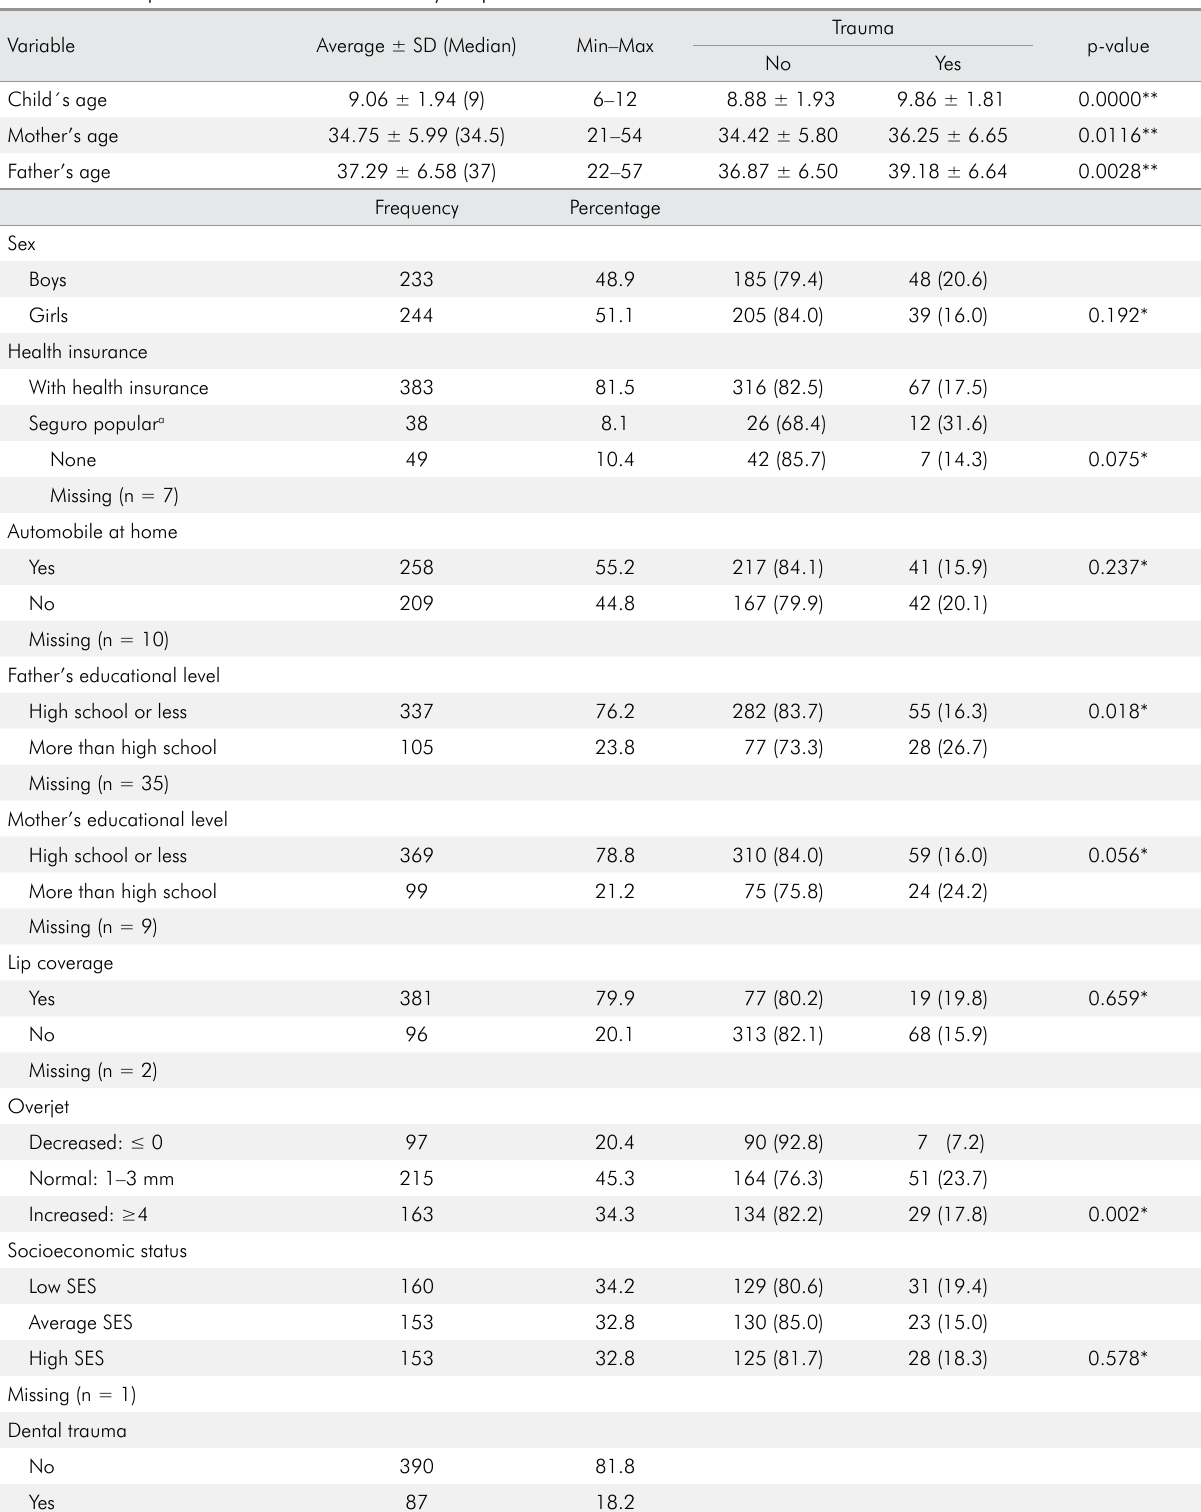
Table 1. Descriptive characteristics of the study